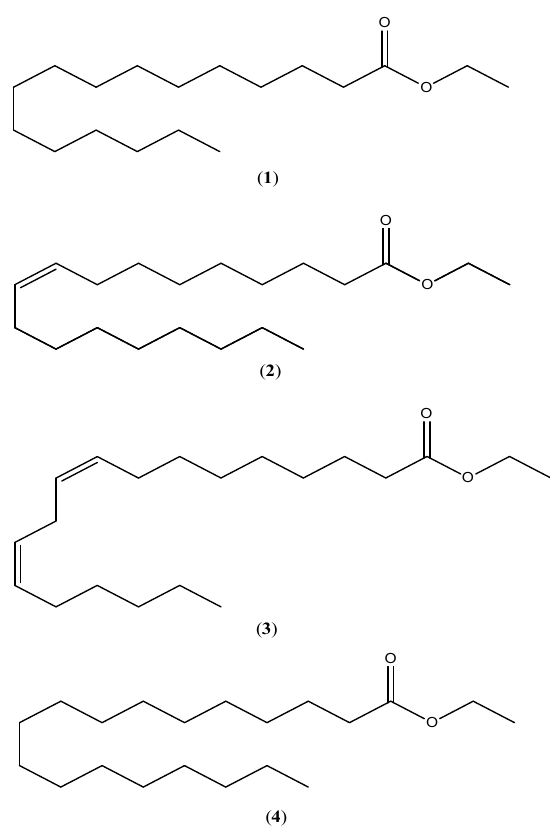
Figure 1. The structures of few fatty esters (FAEEs): ethyl palmitate (1), ethyl oleate (2), ethyl linoleate (3), ethyl stearate